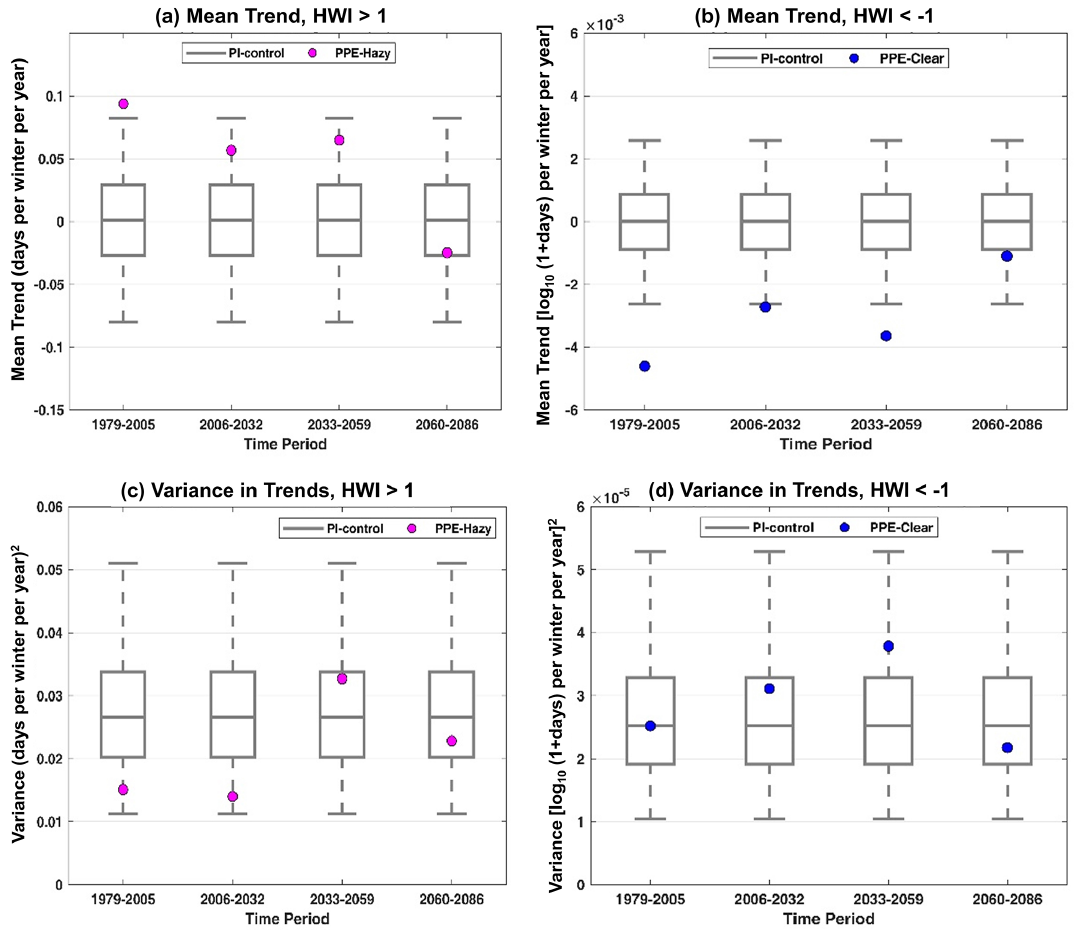
Figure 11. Mean PPE trends for the frequencies of (a) haze-conducive weather (HWI > 1) and (b) clear weather (HWI < − 1) in winter. Circles show the mean trends from 16 PPE members for the historical (1979–2005) and the near-future (2006–2032), mid-future (2033– 2059), and far-future (2060–2086) periods under the RCP8.5 scenario. Each grey box and whiskers shows the distribution of 10000 values of trends sub-sampled from the control simulation. Panels (c, d) show the same as in (a, b) but the mean is replaced by the variance in trends. For each box and whiskers, we first randomly sampled 10000 time series of length 27 years using 2704 years of pre-industrial control simulation and calculated 10000 values of trends. We then randomly sub-sampled 16 trend values from the 10000 trend values and calculated the variance and mean of those 16 trend values. The boxes are at the 25th and 75th percentiles and the whiskers are at the 2.5th and 97.5th percentiles of the mean and variance distributions. For clear days, the frequencies were transformed to log space by applying a power transformation of log 10 (1 + frequency) before calculating